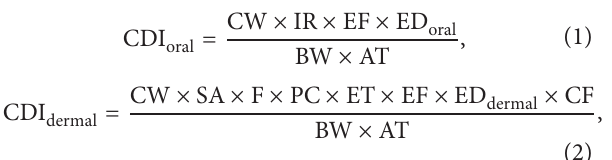
F 1: Map of sampling